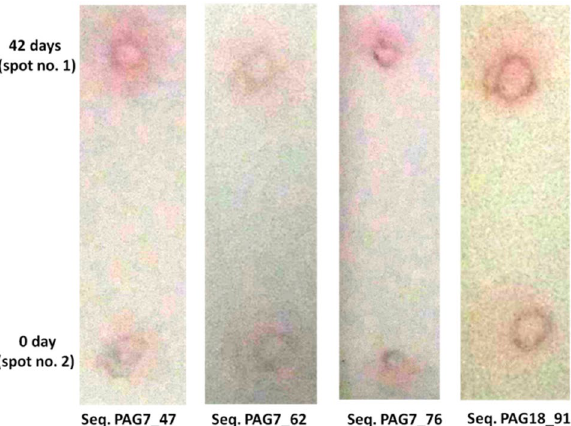
Figure 8. Testing of different aptamers binding affinity for PAG protein in GNP based